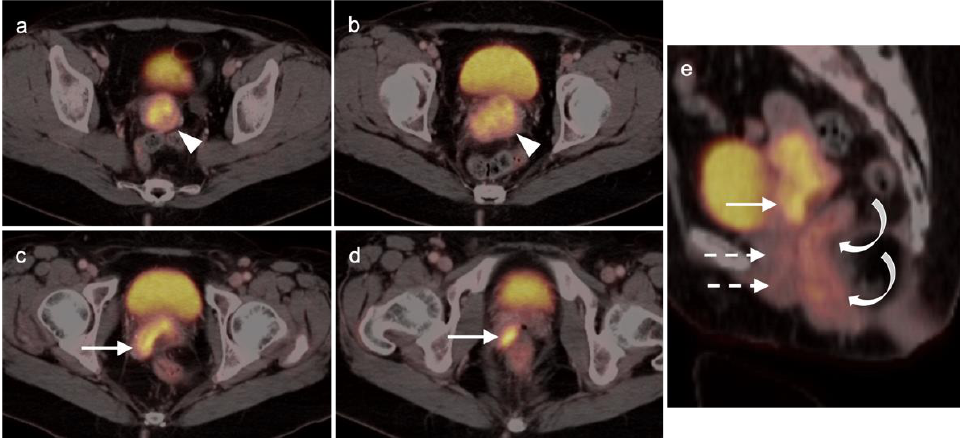
Figure 16. Stage IIA cervical cancer shown by FDG PET-CT images of the pelvis. ( a , b ) Axial FDF PET-CT of the pelvis shows a hypermetabolic tumor involving the entire cervix (white arrowhead); ( c , d ) Tumor extends into the vagina on the right (white arrowhead). ( e ) Sagittal view shows cervical cancer with extension into the upper third of the vagina (white arrow), a normal appearing lower two-thirds of the vagina (dashed white arrows) and normal rectum (curved white arrows).